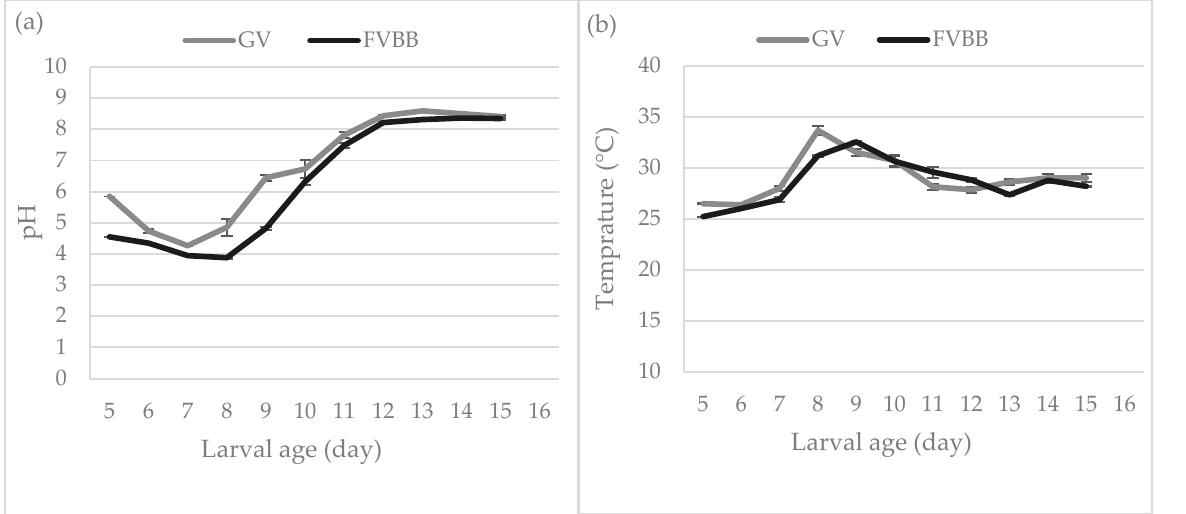
Figure 2. Effect of the Gainesville (GV) and the fruit/vegetable/bakery/brewery (FVBB) diets on: ( a ) pH; ( b ) temperature during BSFL rearing. Error bars represent the standard error of the mean, n = 3.